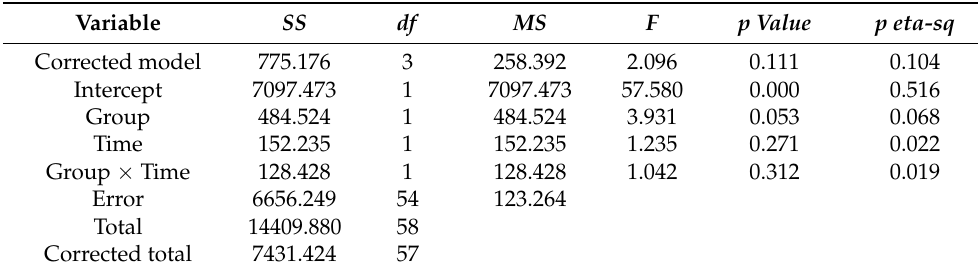
Table 6. Results of two-way ANOVA analysis of